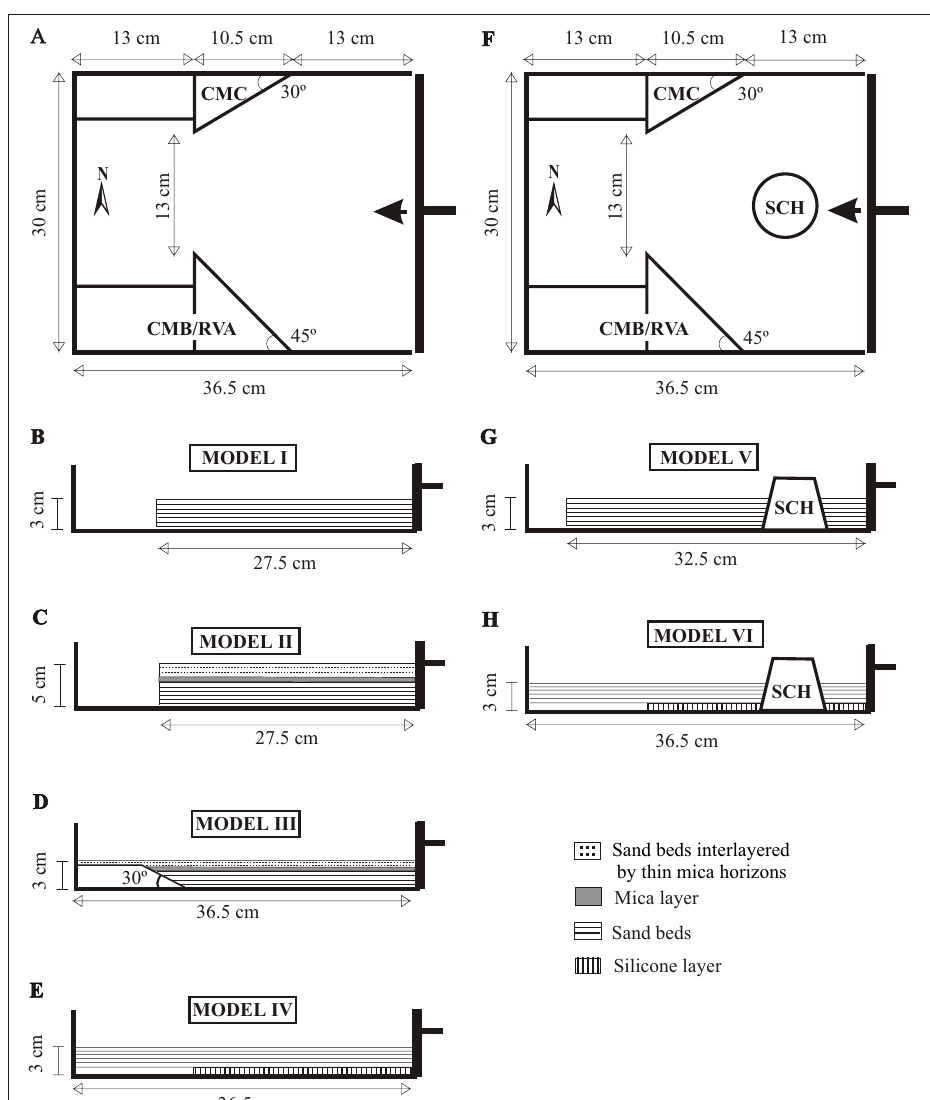
Fig. 2 – Schematic drawings of the experiments with respective boundary conditions. A – Plan-view of the experimental box used for models I to IV. B-, C-, D- and E – East-west sections through experiments I, II, III and IV, respectively. F – Plan-view of the experimental box used for models V and VI. G- and H – East-west sections through the experiments V and VI, respectively. Arrows indicate sense of displacement of the moving wall. SCH – Serra do Caraça structural high; CMC – Caetés Metamorphic Complex; BMC/RVA – Bação Metamorphic Complex/Rio das Velhas